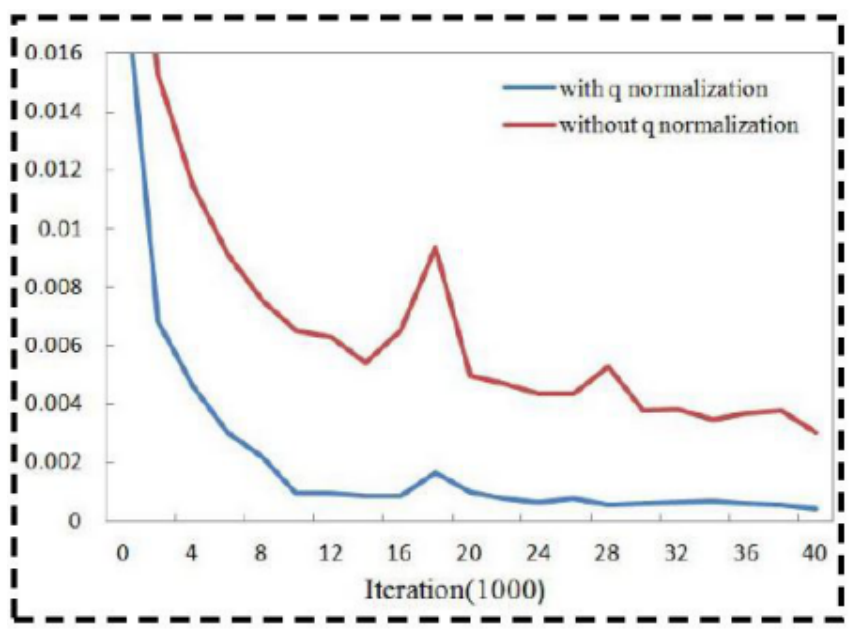
Figure 3. The value of the loss is expressed by the ordinate axis, while the iteration is represented by the abscissa axis.